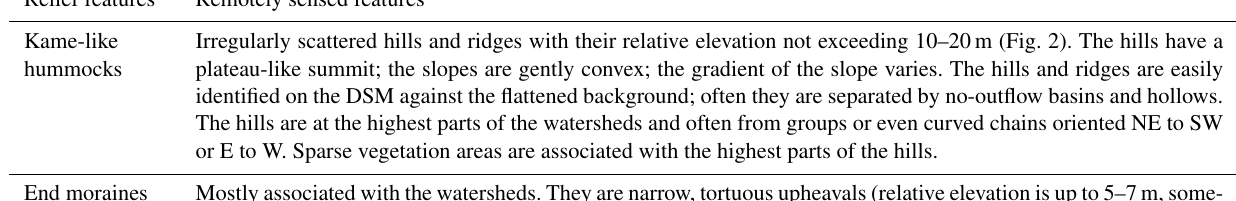
Table 2. Remotely sensed features of glacial and fluvioglacial relief. Relief